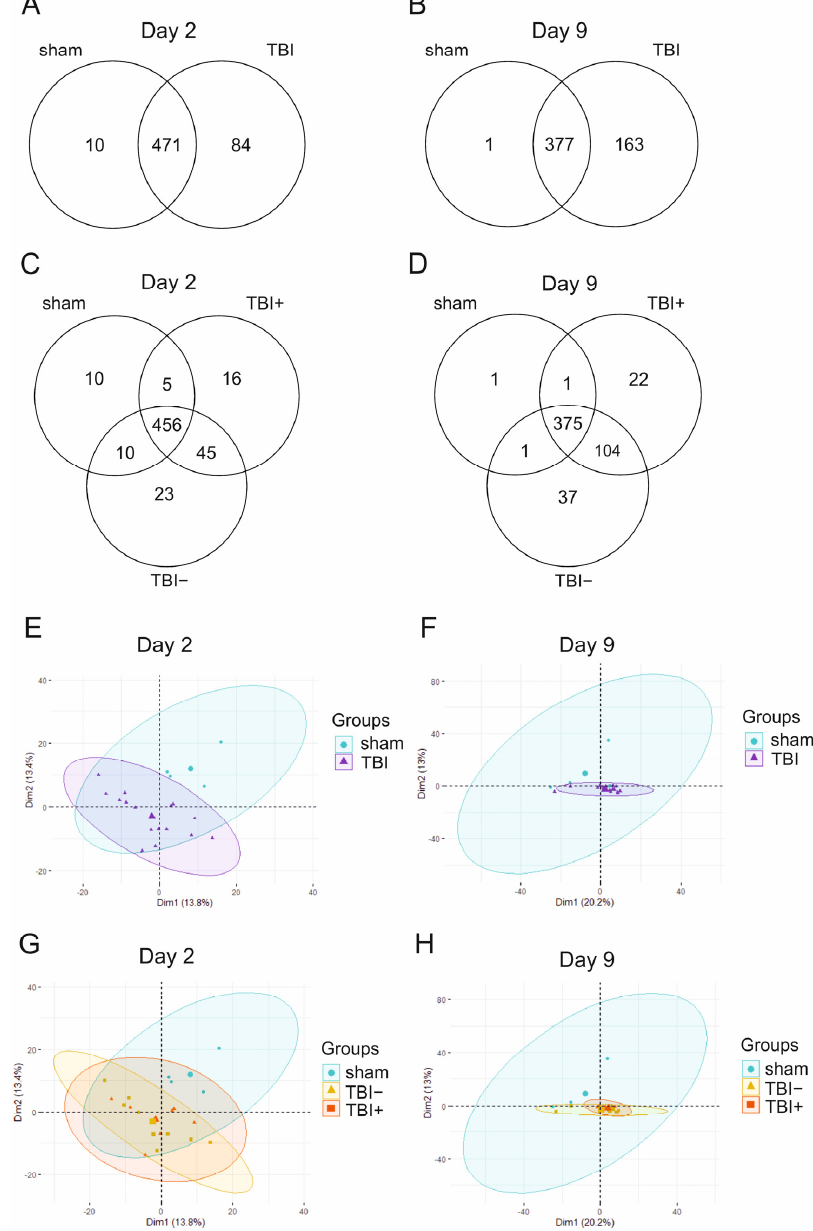
Figure 1. Venn diagrams and principal component analysis (PCA) plots of miRNAs detected in rat plasma by small RNA sequencing. ( A ) A total of 565 miRNAs were detected in rat plasma on day 2 (D2), 471 of which were common between sham and TBI rats. There were 84 miRNAs detected only in the TBI group. ( B ) A total of 541 miRNAs were detected in rat plasma on D9, 377 of which were common between sham and TBI rats. There were 163 miRNAs detected only in the TBI group. ( C ) On D2, 16 miRNAs were detected in the TBI animals with epilepsy (TBI+) but not in the sham group or in TBI animals without epilepsy (TBI − ). These miRNAs, however, were typically found in only 1 sample in the TBI+ group, and the number of reads was very low (<3). ( D ) On D9, 22 miRNAs were detected in the TBI+ group but not in the sham and TBI − groups. As on D2, these miRNAs were typically found in only 1 sample in the TBI+ group and had a very low read number. ( E – H ) According to PCA, the first and second principal components explained 27% of the variance in the data on D2 and 33% on D9. Plasma miRNA expression profile separated sham and TBI rats into different clusters on D2 but not on D9. The miRNA expression profile did not separate TBI+ and TBI − rats at either